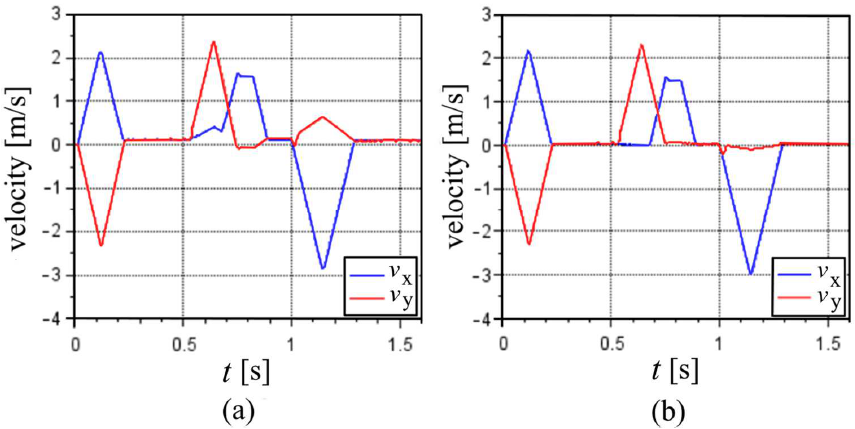
Figure 4. Velocities of the first cycle at 100% MS: ( a ) assuming nominal distances between accelerometer sensors and center of the nozzle, i.e., e values equal to zero. ( b ) Assuming the optimized values for e